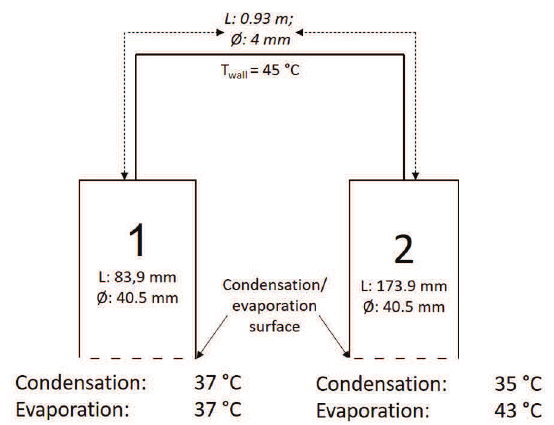
Figure 3. A schematic overview of the system used in the mathecial model. In this model no liquid water is present in both vessels, what is transfered in/out of the system by at the bottom of both vessels